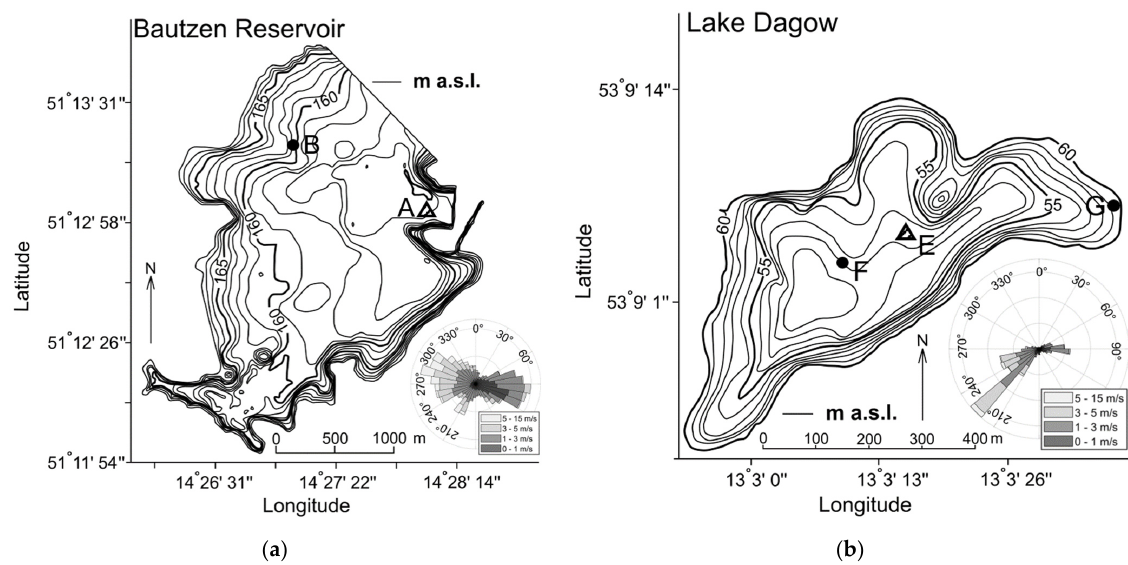
Figure 1. Bathymetric maps of the study sites: ( a ) Bautzen Reservoir; ( b ) Lake Dagow. The plots were created based on the published maps in [24,29]. Black lines show isolines with equal elevation in meters above sea level (m a.s.l.). Small panels on the right show wind roses with wind directions and windspeed. The locations of the instruments are indicated by triangles and circles labeled with capital letters. Points A and E (triangles) mark the locations of the platforms for micrometeorological measurements and the acoustic Doppler current profiler (ADCP). The ADCPs were deployed at the bottom, at a distance of approximately 10 m from the platforms. Points A and F mark the locations of the thermistor chains. A, B and G mark the location of the surface wave observations (pressure sensors). Table 1. Instrumentation and resolution for the water-side and atmospheric measurements conducted in Bautzen Reser- voir and Lake Dagow.